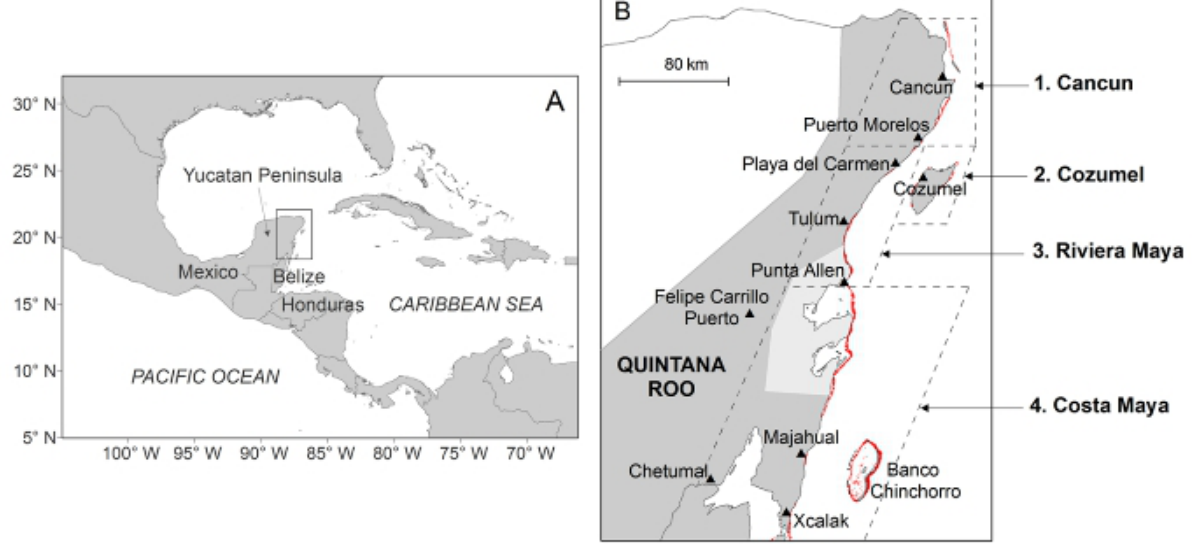
Fig. 1. Maps indicating the location and spatial extent of the model region, with the Mexican state of Quintana Roo shaded in dark gray in (B). The location of coral reefs is indicated in red and includes both fringing reefs and the offshore atoll of Banco Chinchorro. The Sian Ka’an Biosphere Reserve, which is the largest protected area in Quintana Roo, is indicated in light gray (between Tulum and Majahual). Dashed lines delineate the four municipalities used in the coupled